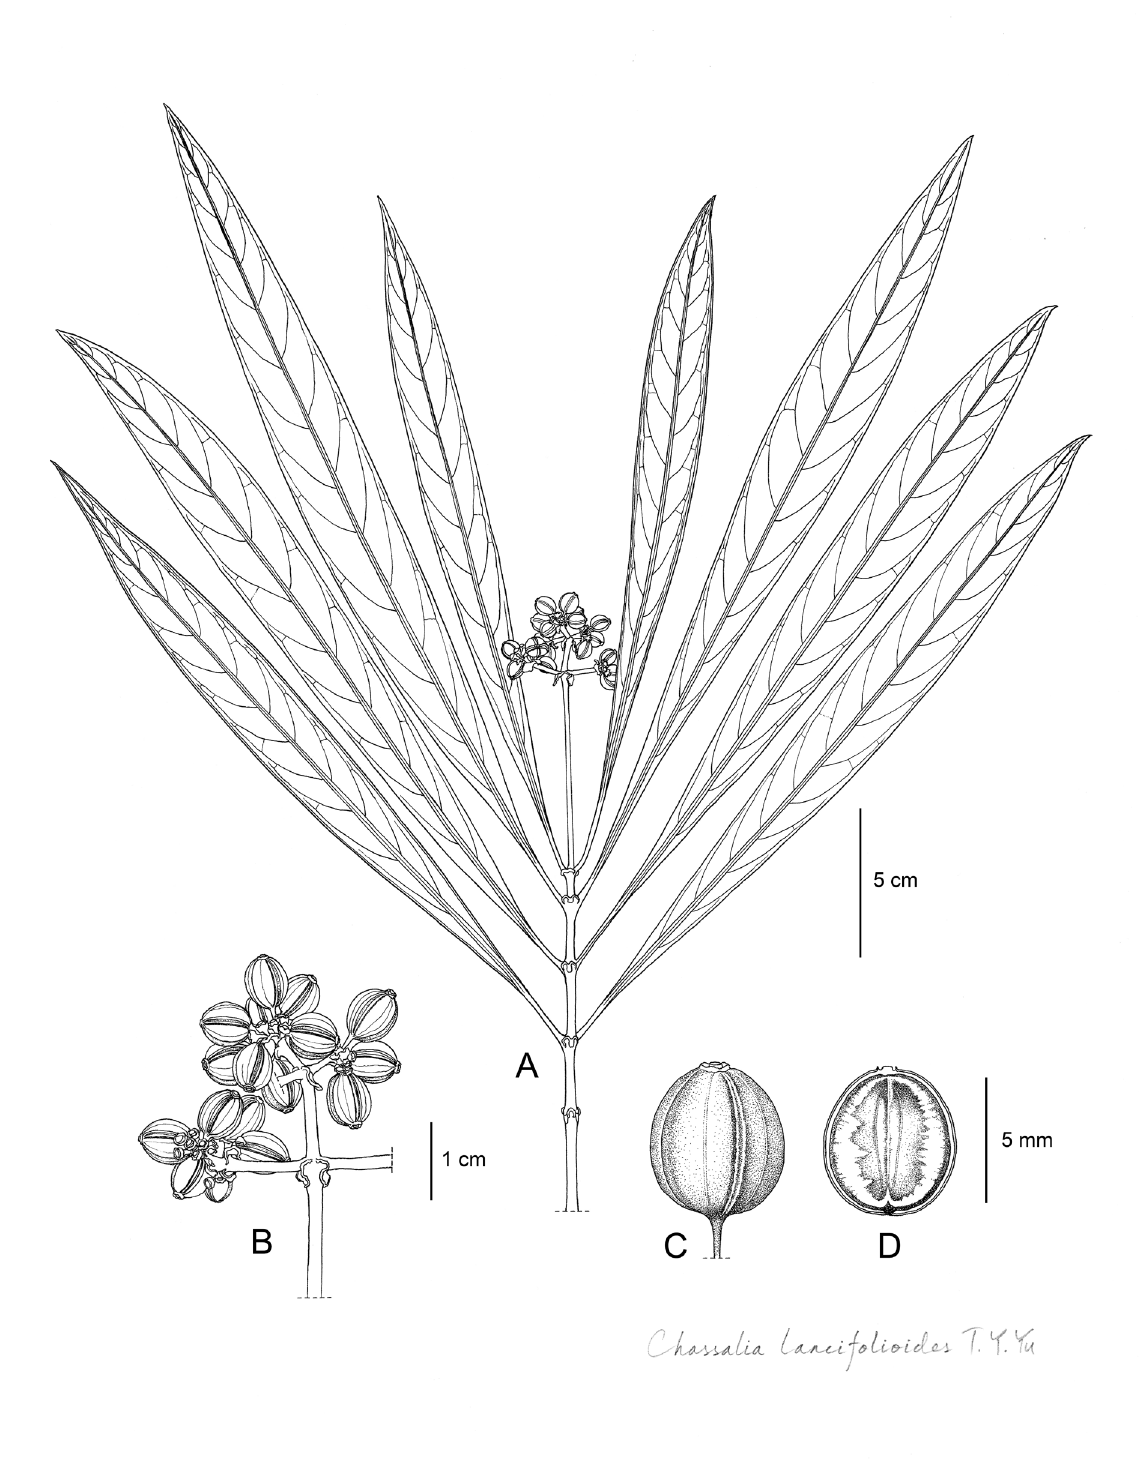
Fig. 18. Chassalia lancifolioides T.Y.Yu sp. nov. A . Flowering shoot. B . Infructescence. C . Dry fruit. D . Pyrene ventral surface. From John H. Beaman 12027. Drawn by T.Y.